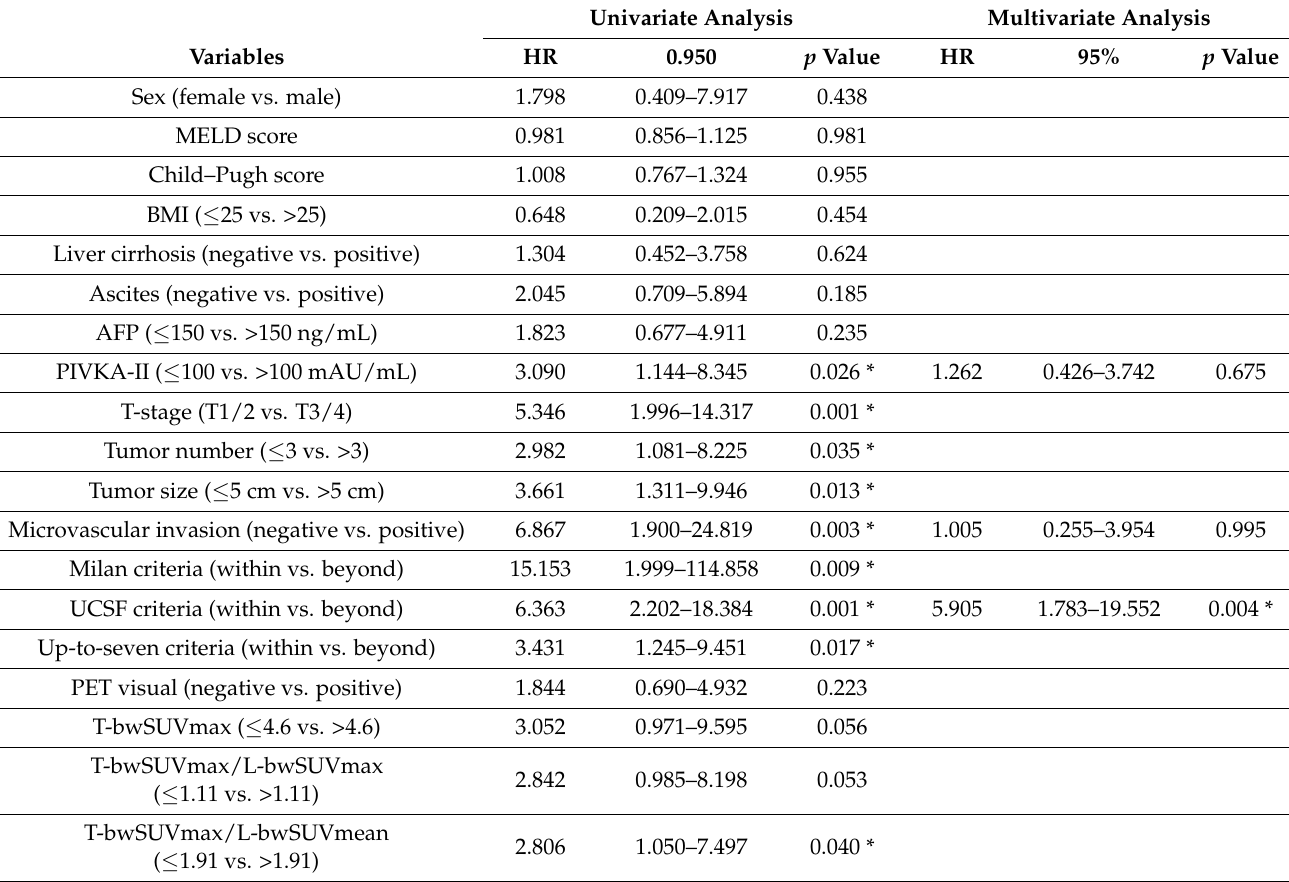
Table 5. Results of univariate and multivariate analyses for prediction of recurrence-free survival. Univariate Analysis Multivariate